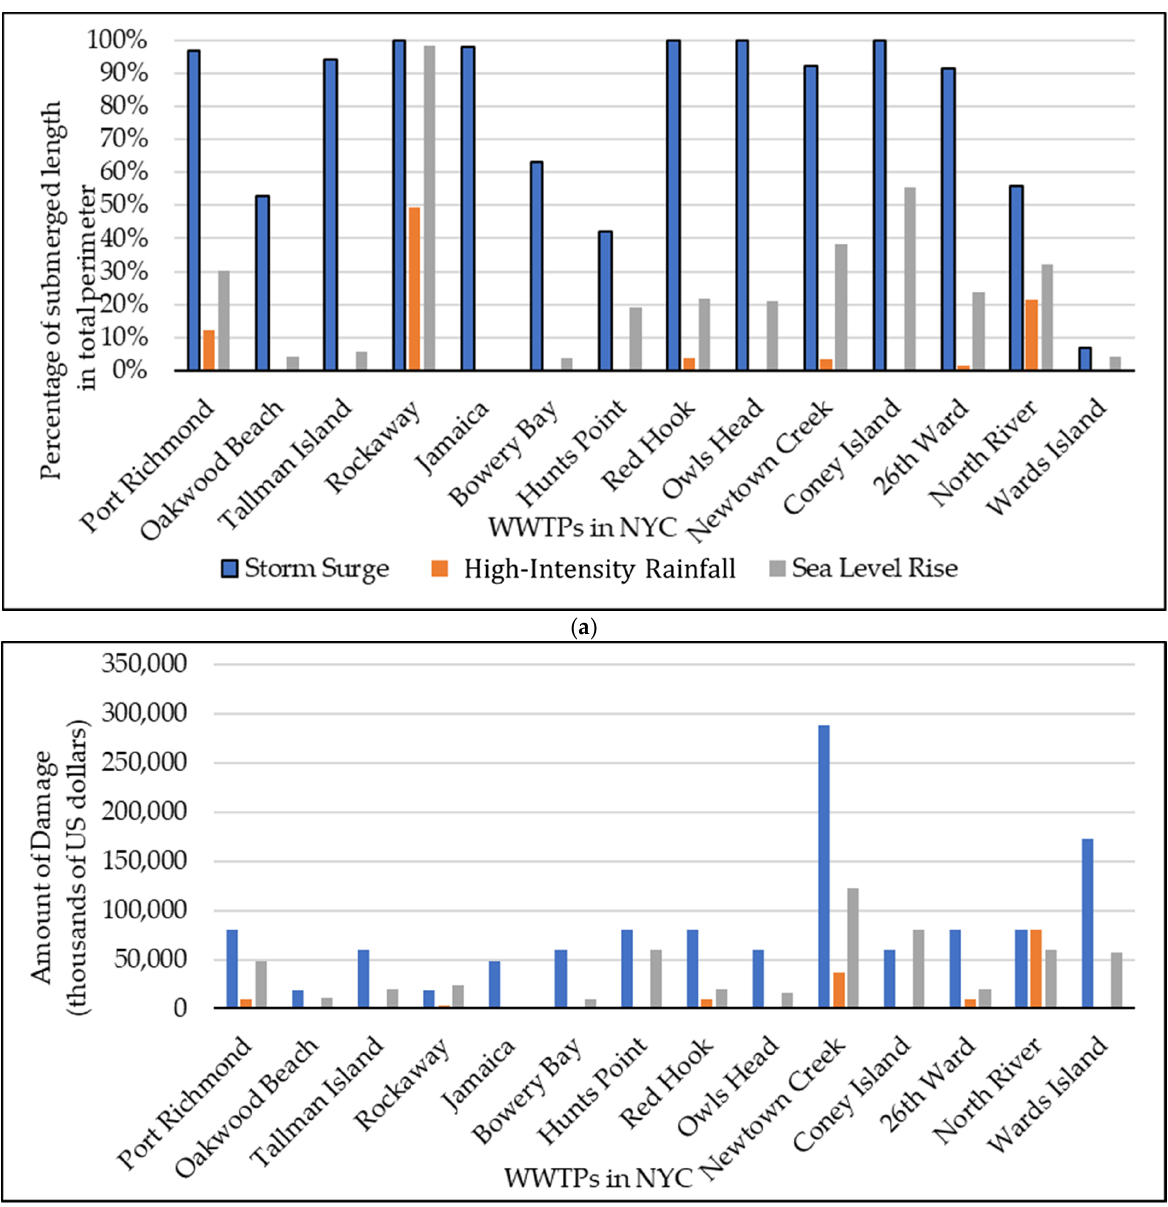
Figure 6. ( a ) Percentage of submerged length caused by three extreme events to 14 WWTPs and ( b ) amount of damage caused by three extreme events to 14 WWTPs.